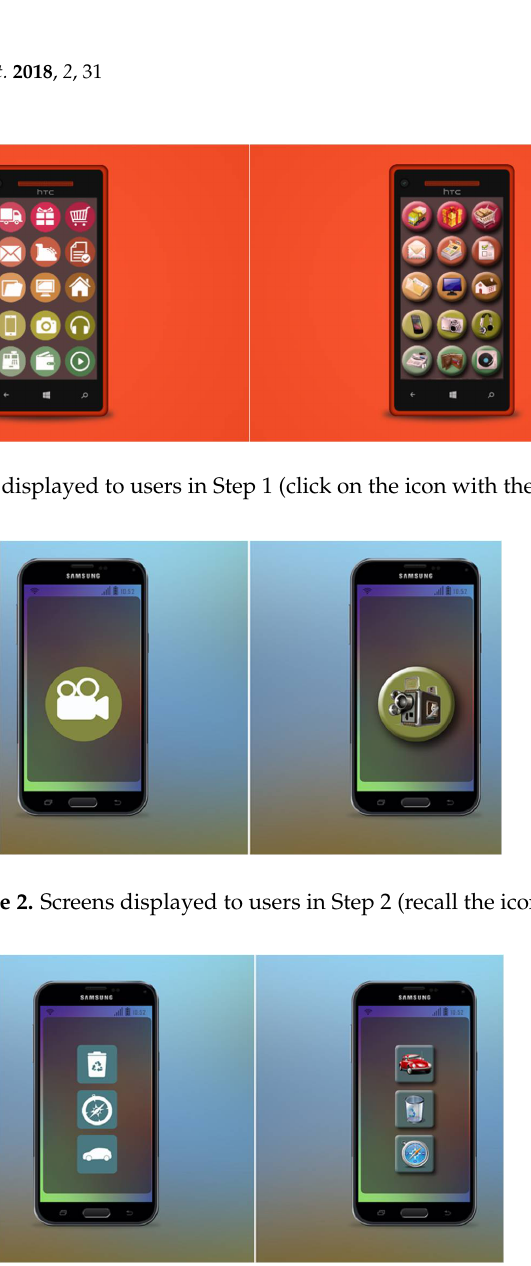
Figure 3. Screens displayed to users in Step 3 (recall the icons).